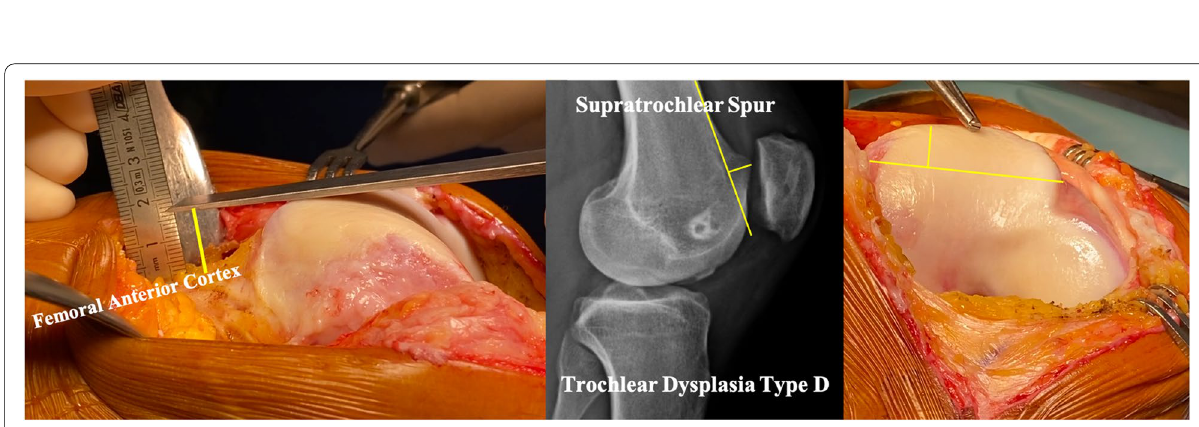
Fig. 2 Definition of the supratrochlear